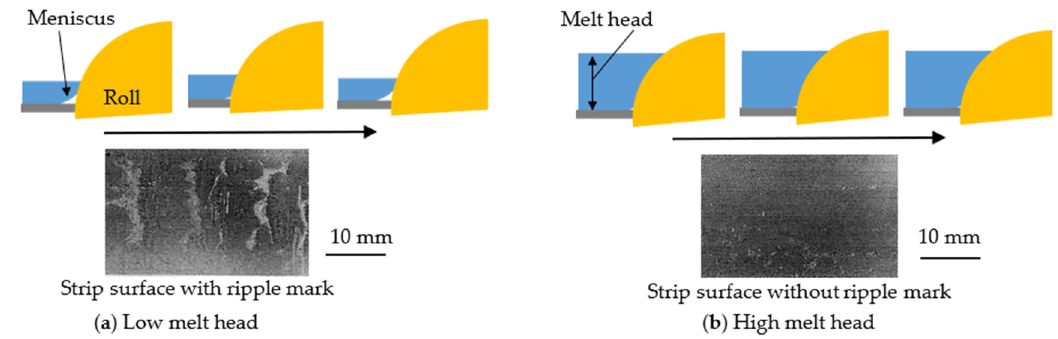
Figure 2. Schematic illustration showing the relationship between the melt head and the stability of meniscus, and photographs of the surface of Al-12%Si trip. ( a ) Low melt head, ( b ) High melt head.